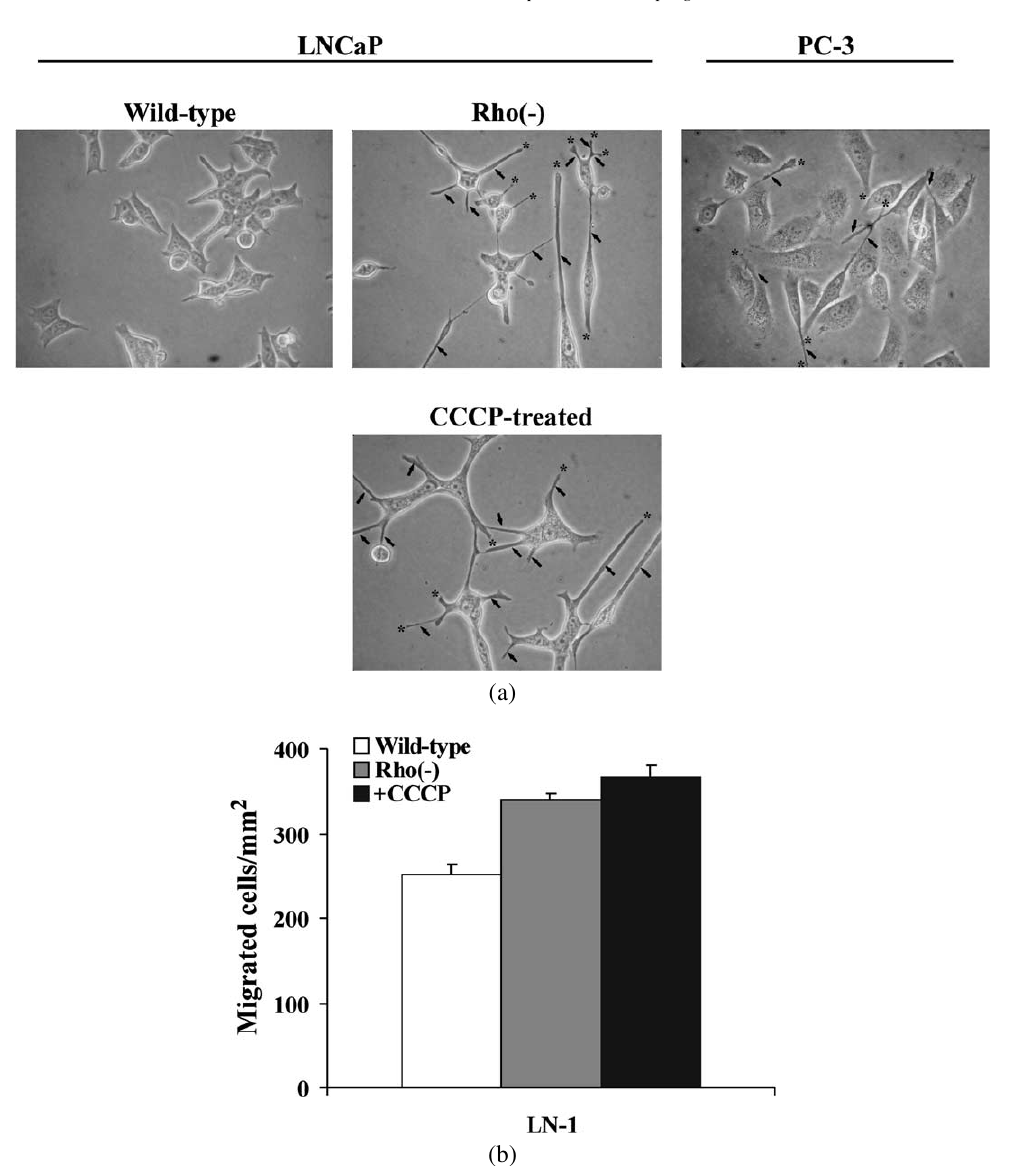
Fig. 5. MtDNA depletion confers an invasive phenotype to LNCaP prostate cancer cells. (a) Morphological changes induced by either genetic or metabolic mitochondrial defects were noticeable by microscopic analysis. Representative pictures of PC-3 cells and wild-type, mtDNA-depleted [Rho( − )] and CCCP-treated (25 µM for 12 h) LNCaP cells are shown (100 × ). Pseudopodia are indicated by arrows and invadopodia along the cell surface or at the end of a dominant leading edge pseudopod are indicated by asterisks. These phenotypic characteristics underline motility and invasive ability. (b) Wild-type, Rho( − ) and CCCP-treated LNCaP cell migration was assessed by plating 1 . 0 × 10 5 cells onto transwell insert filters coated with 10 µg/ml LN-1. After 12 h, cells on the bottom of the filter were fixed, stained with crystal violet and counted. Measurements represent mean ± S.E. of 10 random fields. A representative experiment of two is